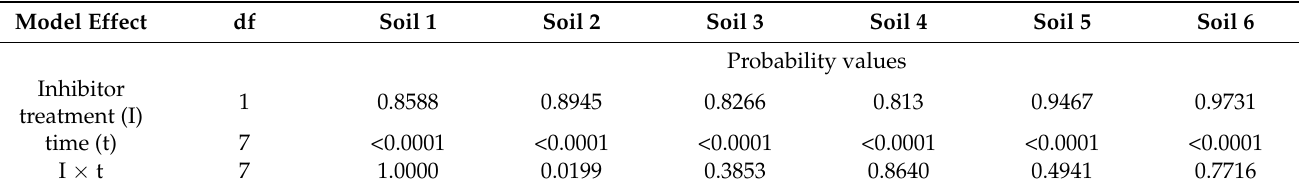
Table 2. Effect of inhibitor treatment and time on % of NBPT recovered in soils.